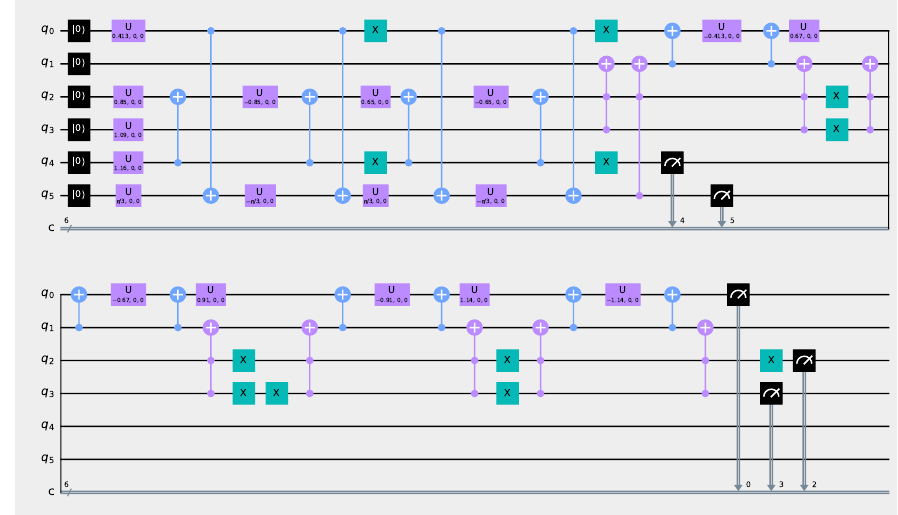
Figure 4. Quantum digital twin for the sensor network shown in Figure